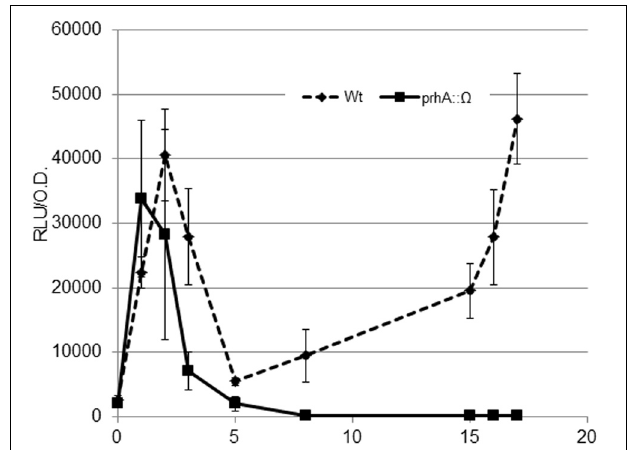
FIGURE 1 | Expression profile of the hrpG promoter during bacterial co-culture with Arabidopsis cells. The wild-type R. solanacearum strain GMI1000 (wt, solid line) or its prhA -defficient derivative (prhA:: (cid:2) , dashed line) carrying the PhrpG::LuxCDABE fusion were grown in Gamborg medium in the presence of plant cells and luminescence measured at different time points. A representative result using three biological replicates is shown. Promoter output is presented as relative luminescence units (R.L.U) produced by the lux reporter corrected by cell density estimated by OD 600 . Error bars indicate standard